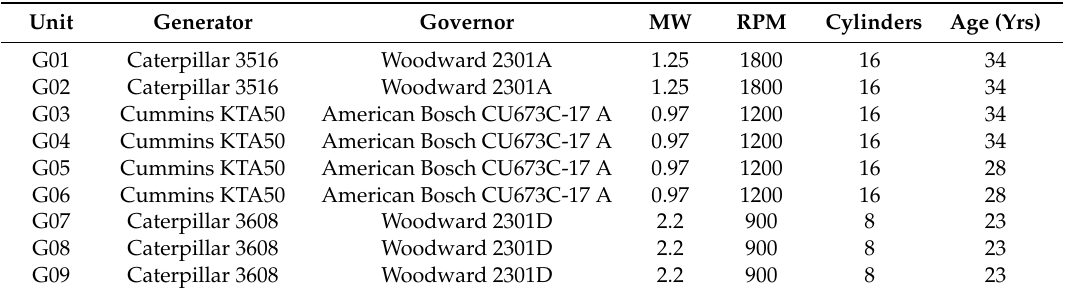
Figure 6. Moloka‘i average daily load profile 2016 (orange), 2017 (blue) and 2018 (purple). Note the reduction in midday load under increasing solar photovoltaic (PV) penetration [19]. Table 4. Moloka‘i’s P¯al¯a‘au Power Station